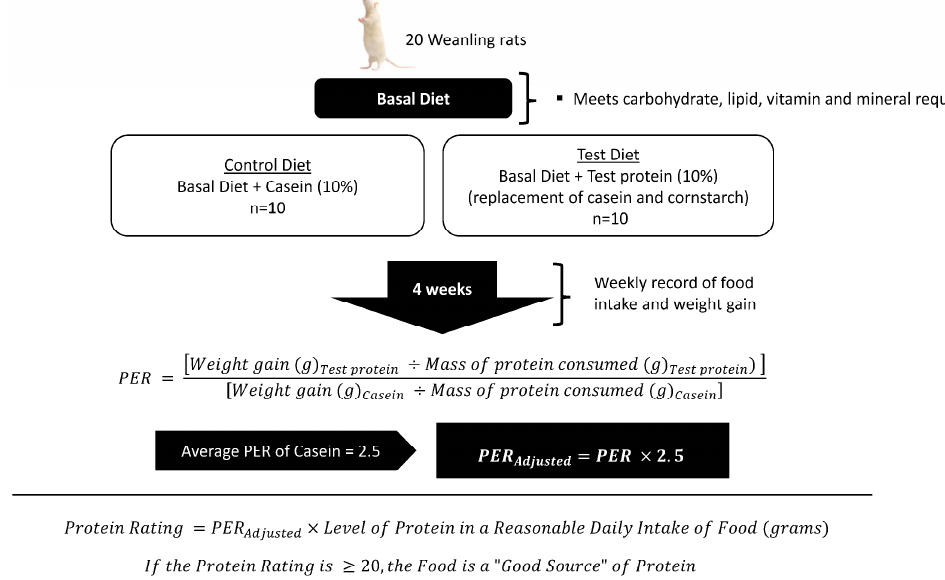
Figure 1. Canadian regulatory framework for protein content claims where the adjusted PER is used to generate a protein rating for a given food [16]. The PER of 2.5 represents the standardized protein rating for casein. It is used to account for intra-laboratory variation and normalize PER values that are generated by the in vivo rat bioassay [14]. PER, protein efficiency ratio. Figure 1 was adapted from Marinangeli and House [15].